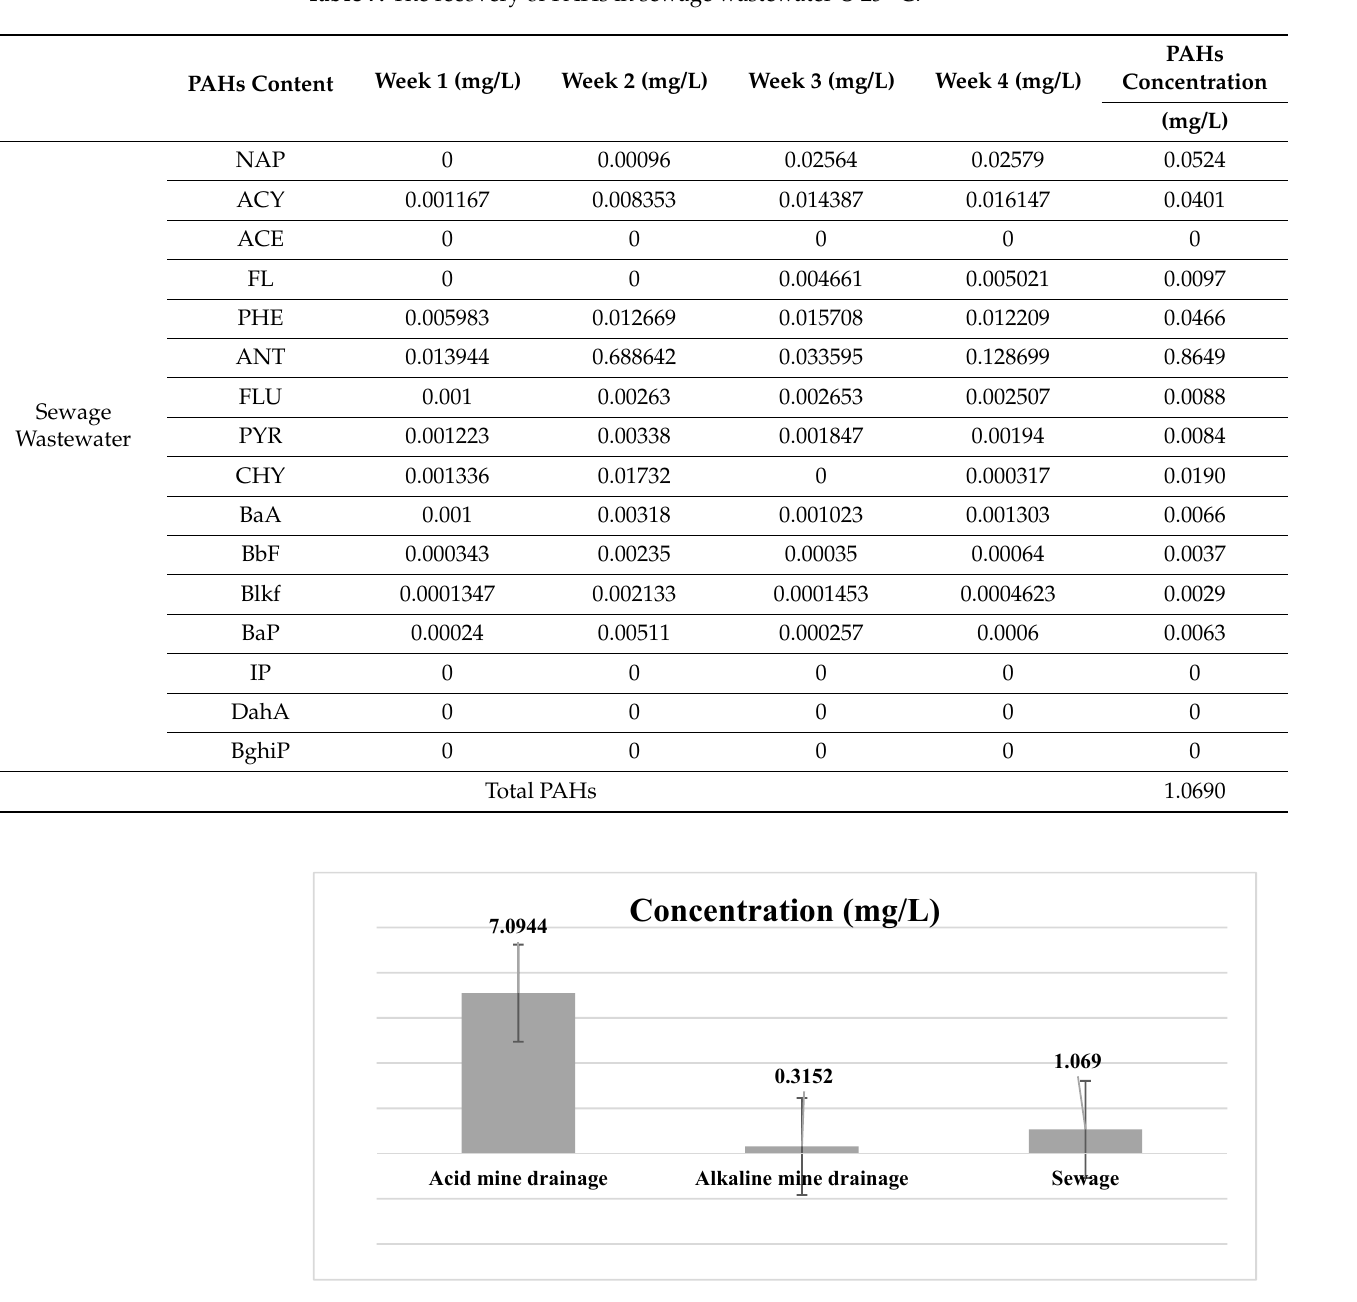
Table 7. The recovery of PAHs in sewage wastewater @ 25 ◦ C.